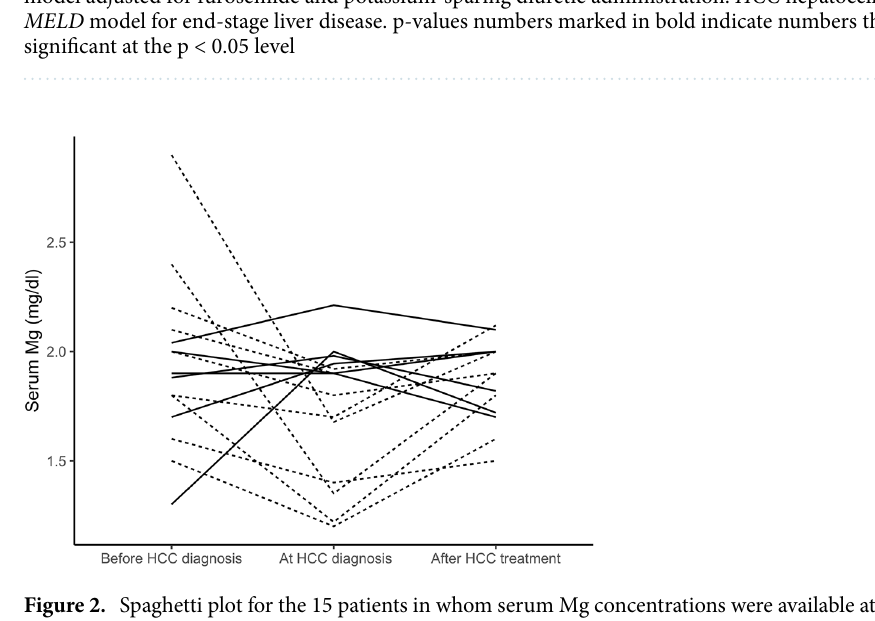
Figure 2. Spaghetti plot for the 15 patients in whom serum Mg concentrations were available at all three time points (i.e. before HCC diagnosis, at tumor diagnosis and after locoregional treatment). The dotted lines represent patients in whom the serum Mg concentration decreased at the diagnosis of HCC compared to before and then increased subsequently after locoregional treatment. Other patients who did not show such temporal changes in serum Mg are represented by the solid